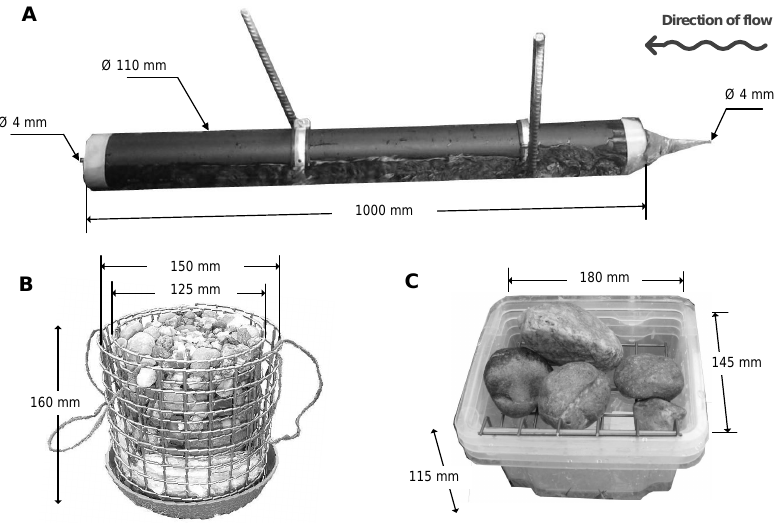
Fig. 2. Devices used to measure fine sediment dynamics in the redds. (A) : suspended sediment sampler, (B) : sediment infiltra- tion/accumulation basket, (C) : bedload